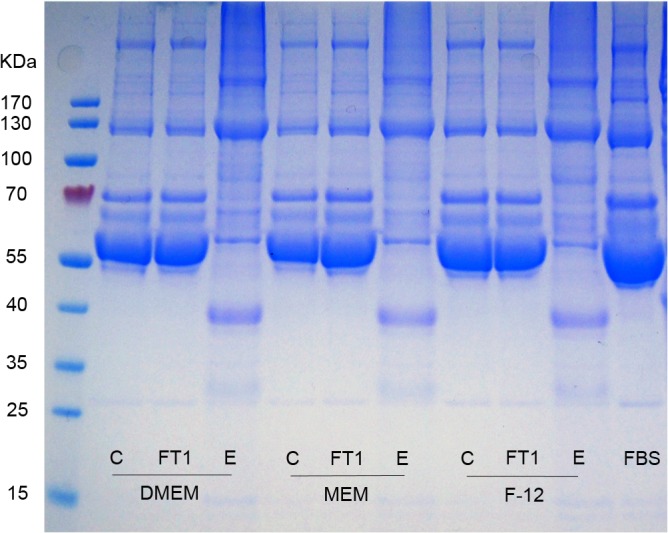
Sodium dodecyl sulfate electrophoresis under nonreducing conditions.Molecular weight protein markers (left lane); start growth medium (C); flow-through (FT) and eluate (E) of QSD-filtered FBS and growth media (DMEM, MEM, and F-12K) containing 10% FBS. Total protein content in each lane was 20 μg. kDa: kilodaltons